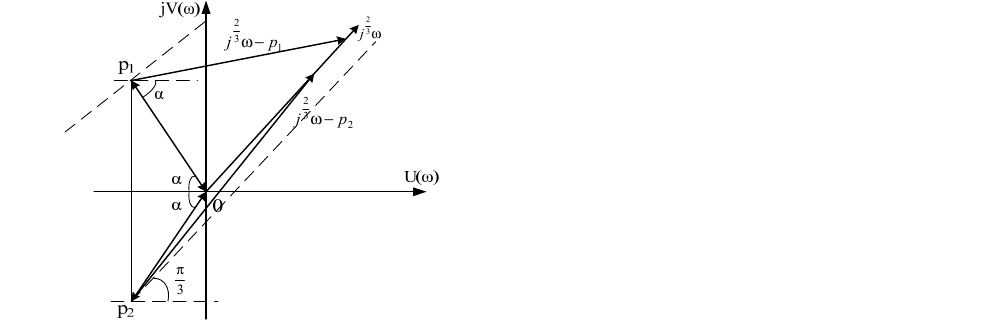
Figure 23. Vector displacement for the first two complex-conjugate roots for this case, when 𝜔 𝜖 (0, ∞) .